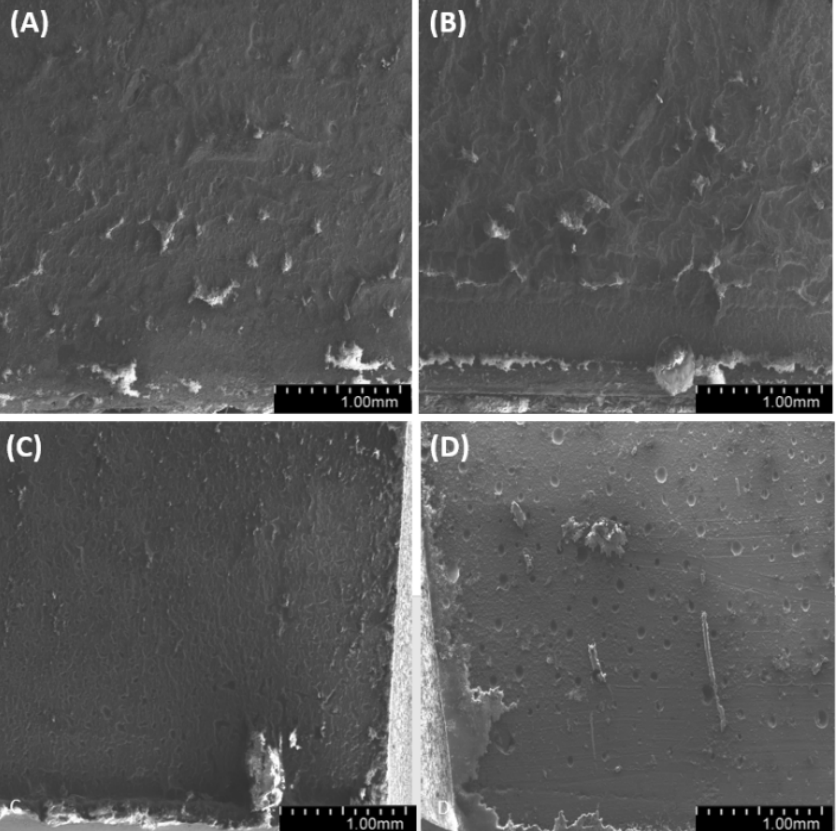
Figure 27. SEM images of mold wall with 70% vol. of diatoms: ( A )—base deg, ( B )—base no deg, ( C )—fractionated deg, ( D )—fractionated no deg.